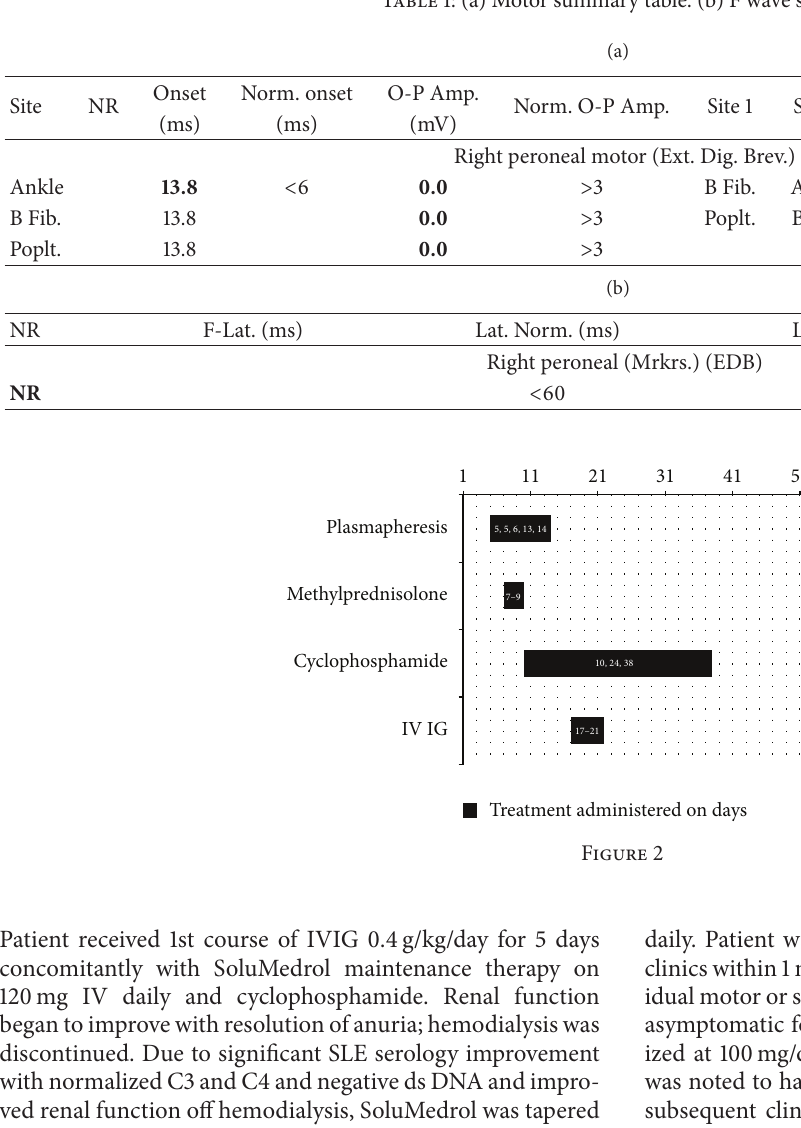
Table 1: (a) Motor summary table. (b) F wave